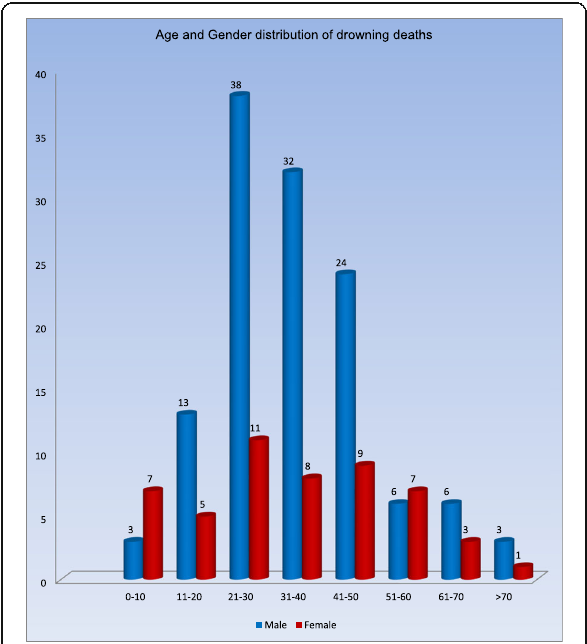
Fig. 1 Age and Gender distribution of drowning